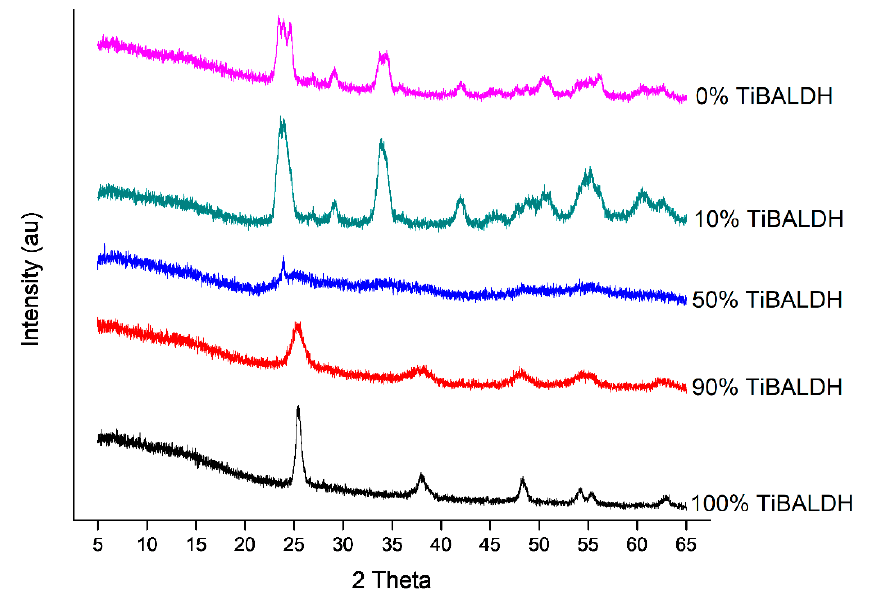
Figure 7. XRD patterns of the fibers after annealing.